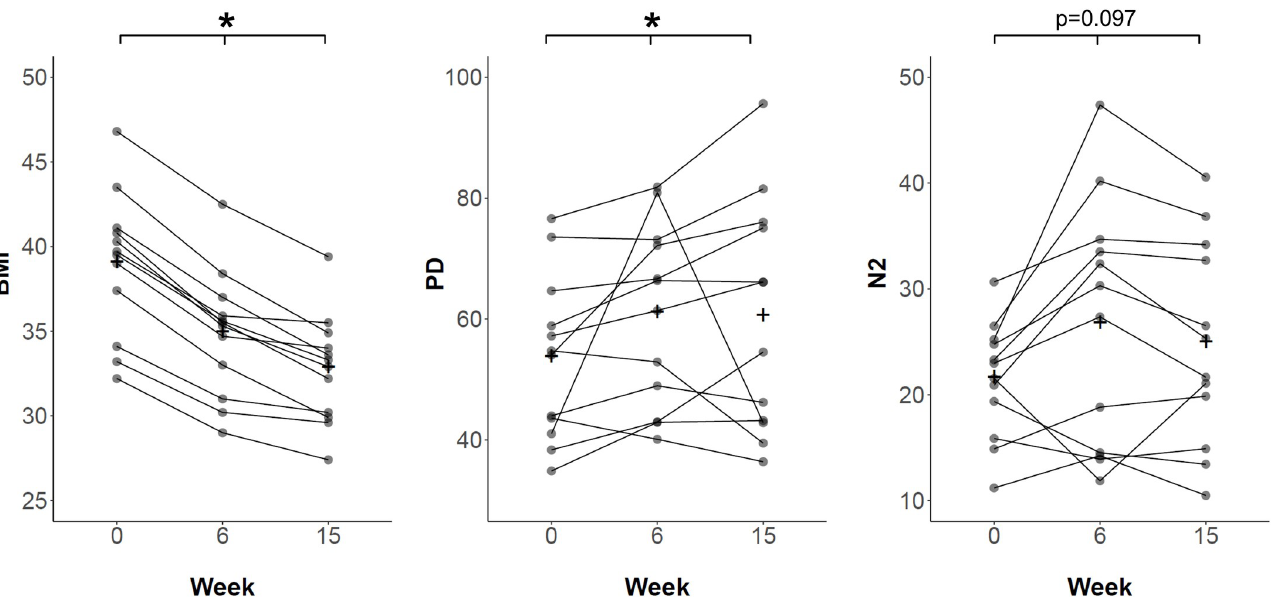
Fig 2. Development of body mass index and alpha diversity indices over the study course. Plots are portraying the changes of body mass index (BMI, left), Phylogenetic diversity (PD, middle) and Simpson diversity number (N2, right) at baseline/0 weeks, after six weeks of low-calorie formula diet and after regular food reintroduction at fifteen weeks. At each time point paired samples of 12 participants were evaluated. Samples corresponding to one individual are connected by a black line. + signs indicate the means. The decrease of BMI during the study was associated with an increase of PD. � indicates significant difference determined by Friedman